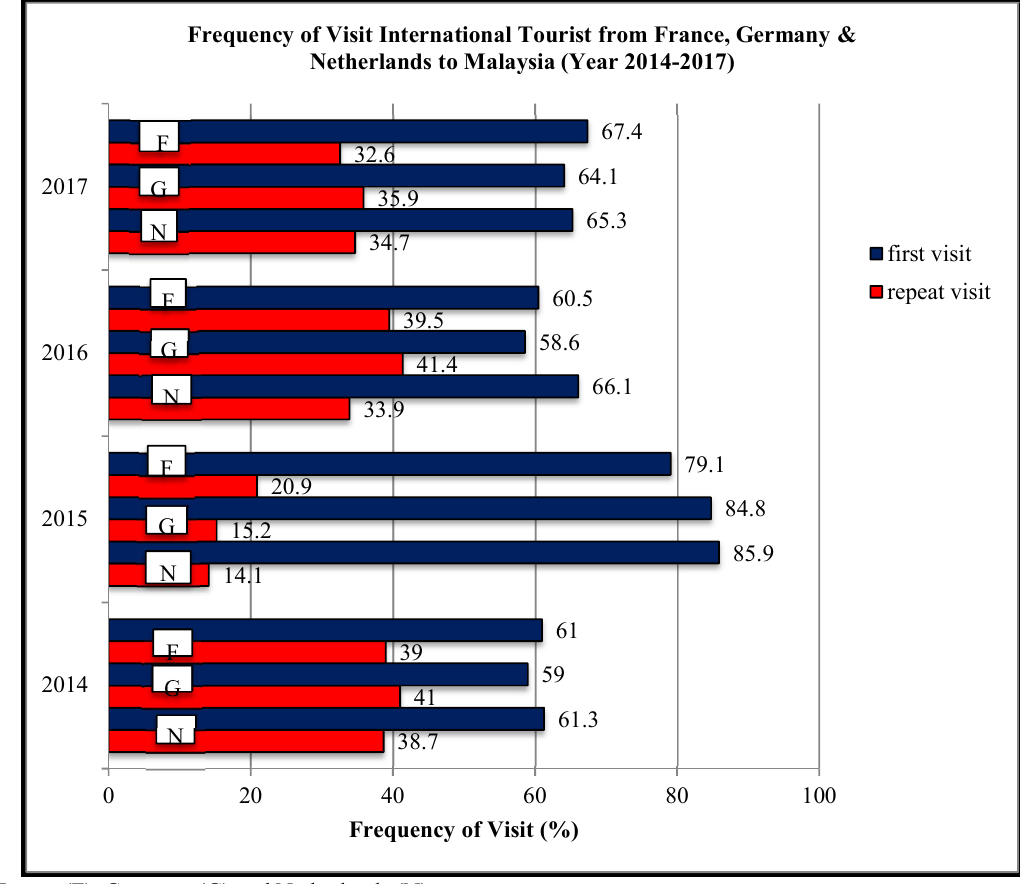
Fig. 1. Frequency of Visit of Tourist from France, Germany and Netherlands to Malaysia in the year 2014 to 2017 Source: Tourism Malaysia (2014; 2015; 2016;